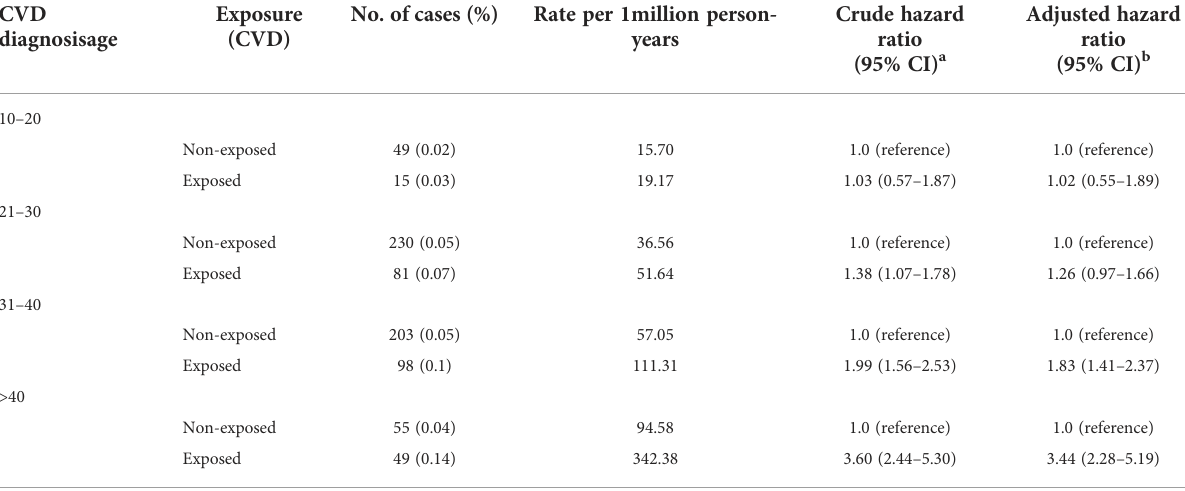
TABLE 1 Associations of overall CVD with lung cancer incidence by age at CVD diagnosis.